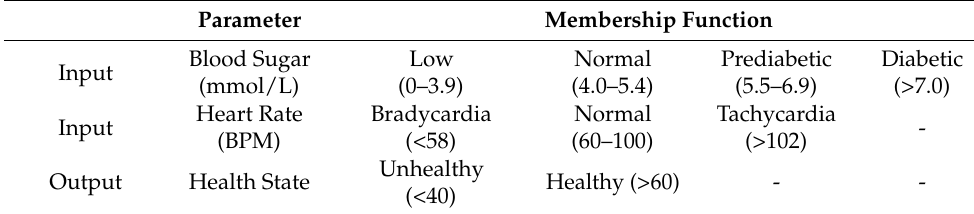
Table 4. Parameters for fuzzy system to diagnose